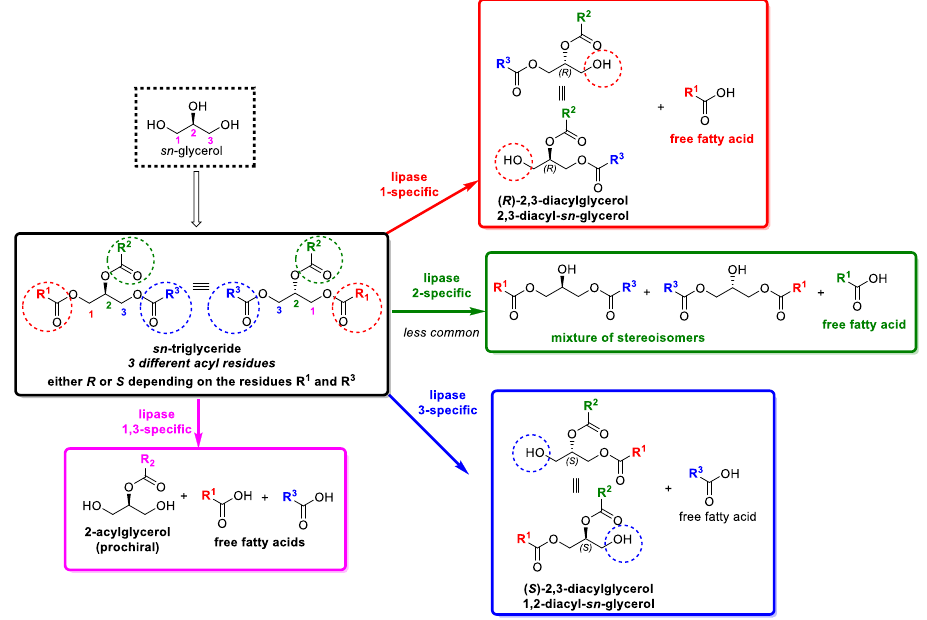
Figure 9. Diversity of reaction products in the first step of a lipase-catalyzed hydrolysis of a triglyceride possessing three different acyl residues (R1, R2 and R3), according to the lipase specificity (1-specific, 3-specific, 1,3-specific or 2-specific).